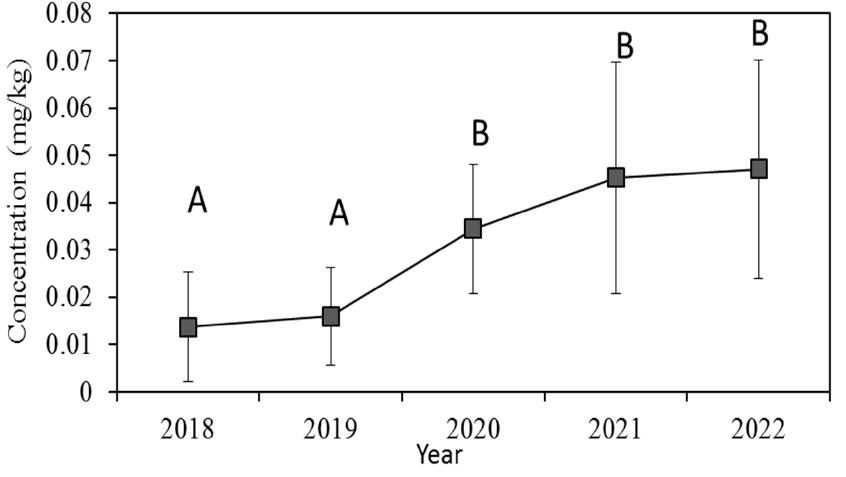
Figure 4. Concentrations of Cd in vegetables in different sampling years. The lines without the same letter are significantly different at P <0.05.